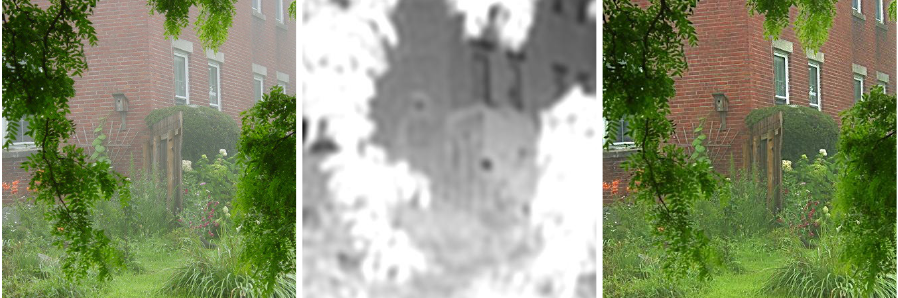
Figure 2. An example of our proposed sparse contextual representation-based dehazing method. From left to right—the hazy input, the estimated transmission map by the proposed algorithm, and the dehazed